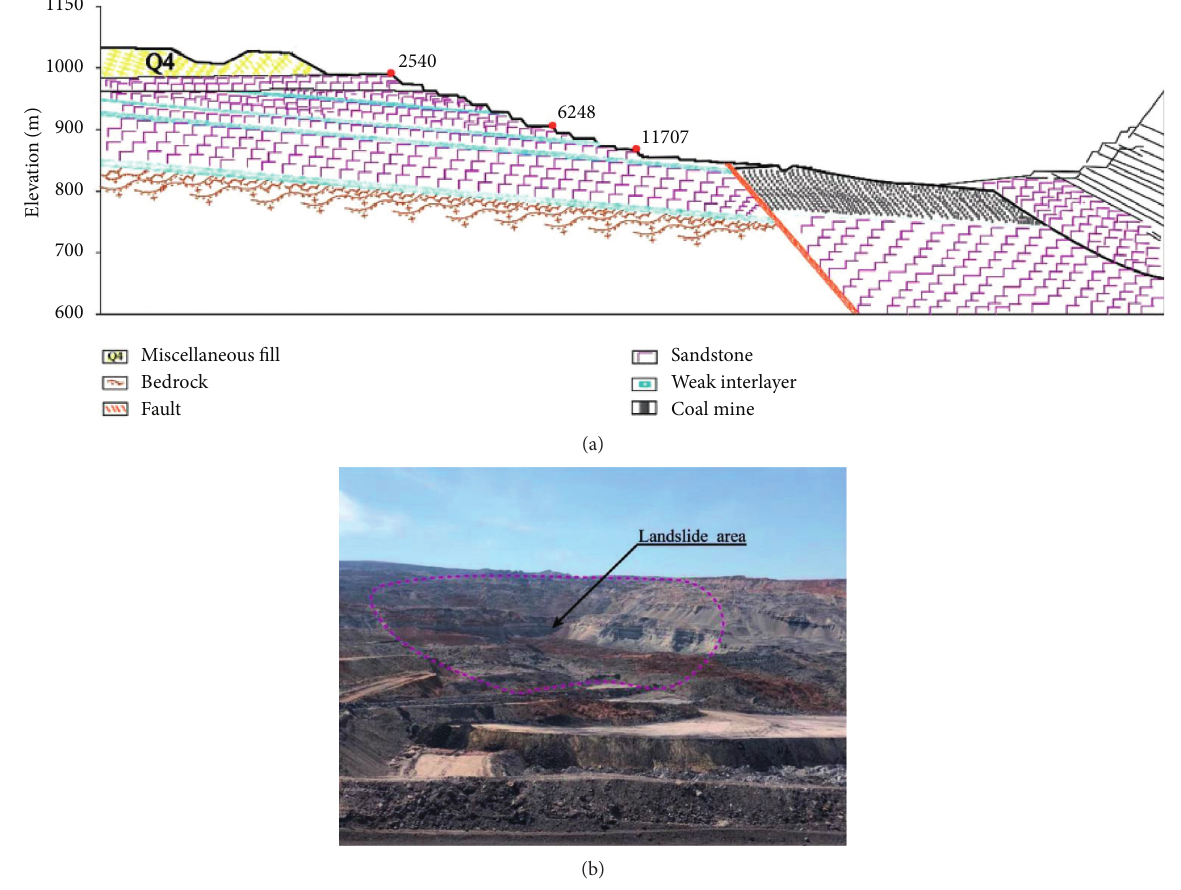
Figure 2: The geomorphology of the slope. (a) The geological section of east No. 2 slope. (b) The topography of the slope. Table 1: Material parameters in the case